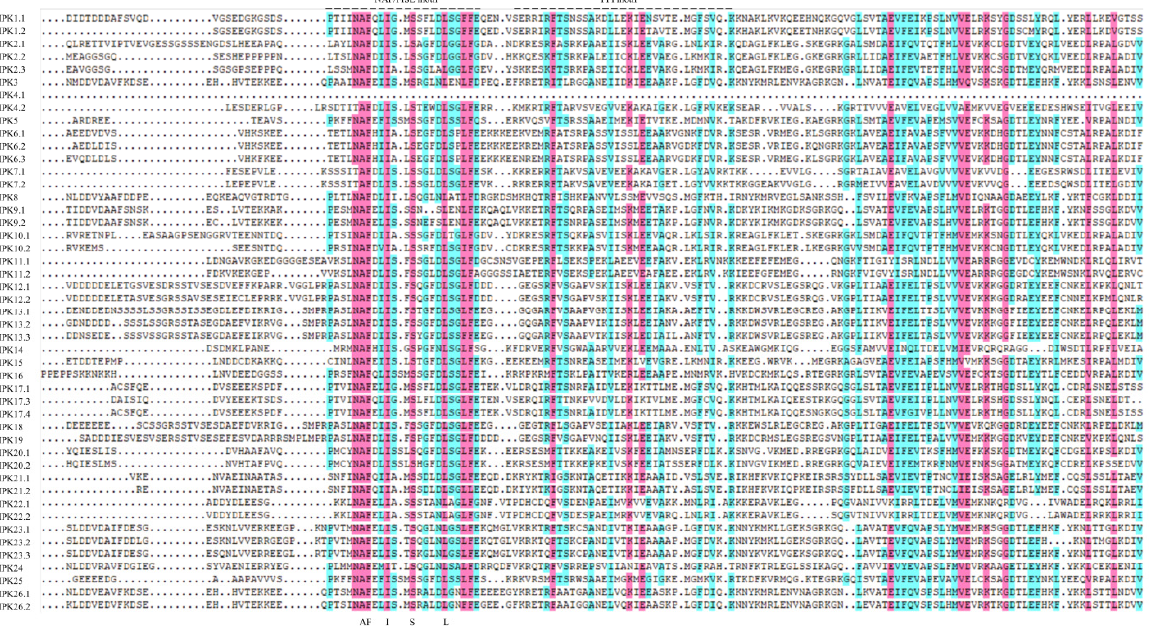
Figure 4. Multiple sequence alignments of 47 BraCIPKs amino acids. The conserved NAF/FISL and protein-phosphatase interaction (PPI) motifs of CIPK are marked by dots above the sequence.